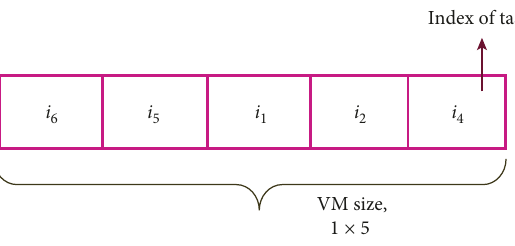
Figure 4: Dynamic scheduler model solution